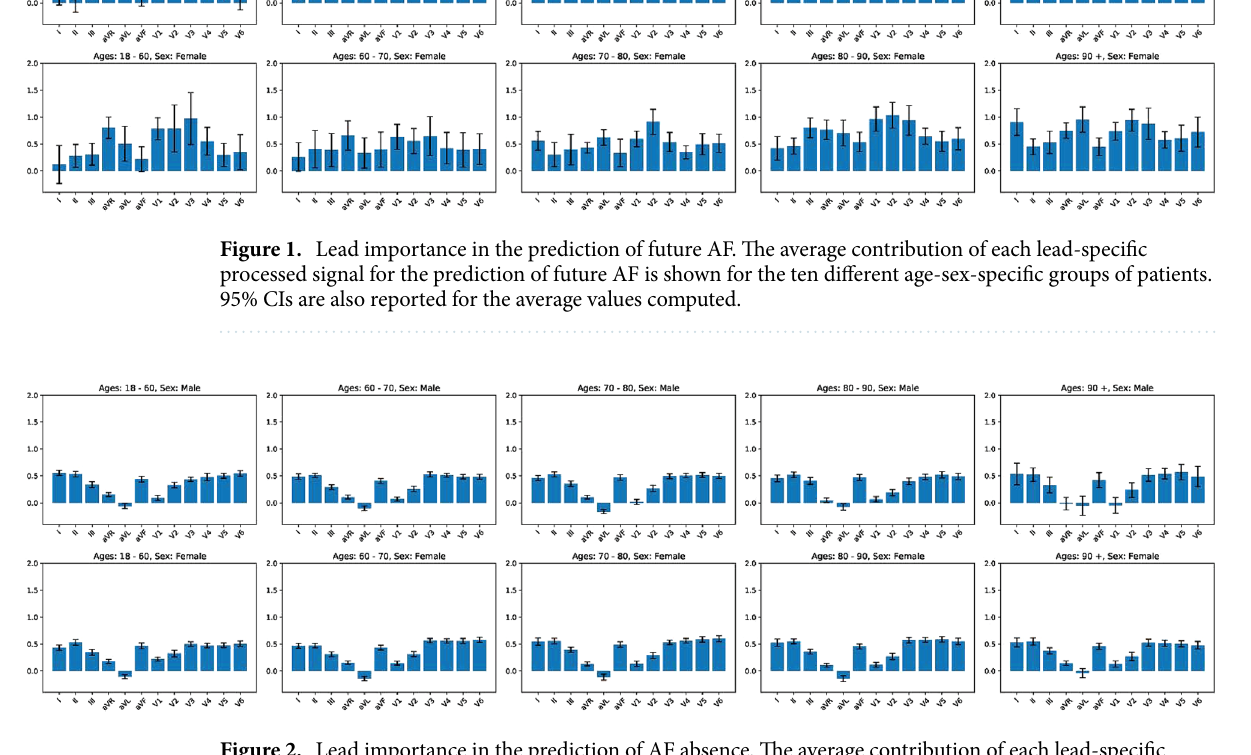
Figure 2. Lead importance in the prediction of AF absence. The average contribution of each lead-specific processed signal for the prediction of AF absence is shown for the ten different age-sex-specific groups of patients. 95% CIs are also reported for the average values